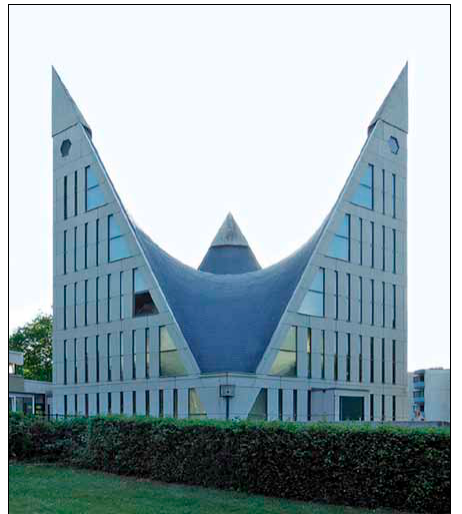
fig. 12. Pilgrim church, Paul Gösch, 1920. Project. Source : W. Pehnt, Die Architektur des Expressionismus . Hatje, Stuttgart 1975: 39, figs. 60 and 61.